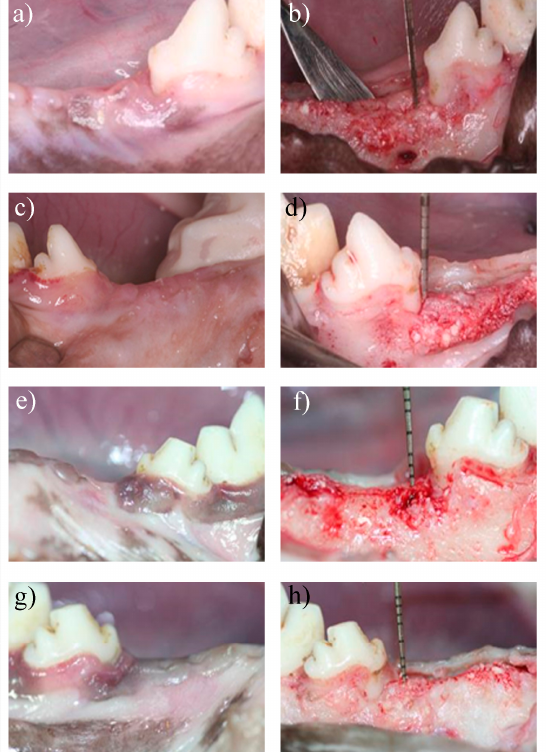
Figure 4. Surgical sites at 4 and 8 weeks post-surgery. In vivo observation of surgical sites and tissue regeneration at 4 and 8 weeks post-surgery. ( a ) Four weeks after surgery, the area treated with the test collagen membrane healed uneventfully; ( b ) Same surgical side from 4a image, the flap was elevated, and the bone defects demonstrated healing with a bone-like tissue; ( c ) Four weeks after the surgery, the area treated with the control membrane healed uneventfully; ( d ) The flap was elevated in same surgical side from 4c image, and the bone defect demonstrated healing with a bone-like tissue. Measurements from the cemento enamel junction (CEJ) showed the regained alveolar ridge height with a periodontal probe; ( e ) Eight weeks after surgery, the area treated with the test collagen membrane healed uneventfully; ( f ) Same surgical side from 4e image, the flap was elevated, and the bone defect demonstrated healing with a bone-like tissue; ( g ) Eight weeks after the surgery, the area treated with the control membrane healed uneventfully; ( h ) The flap was elevated in same surgical side from 4g image, and the bone defect demonstrated healing with a bone-like tissue. Measurements from the CEJ showed the regained alveolar ridge height with a periodontal probe.